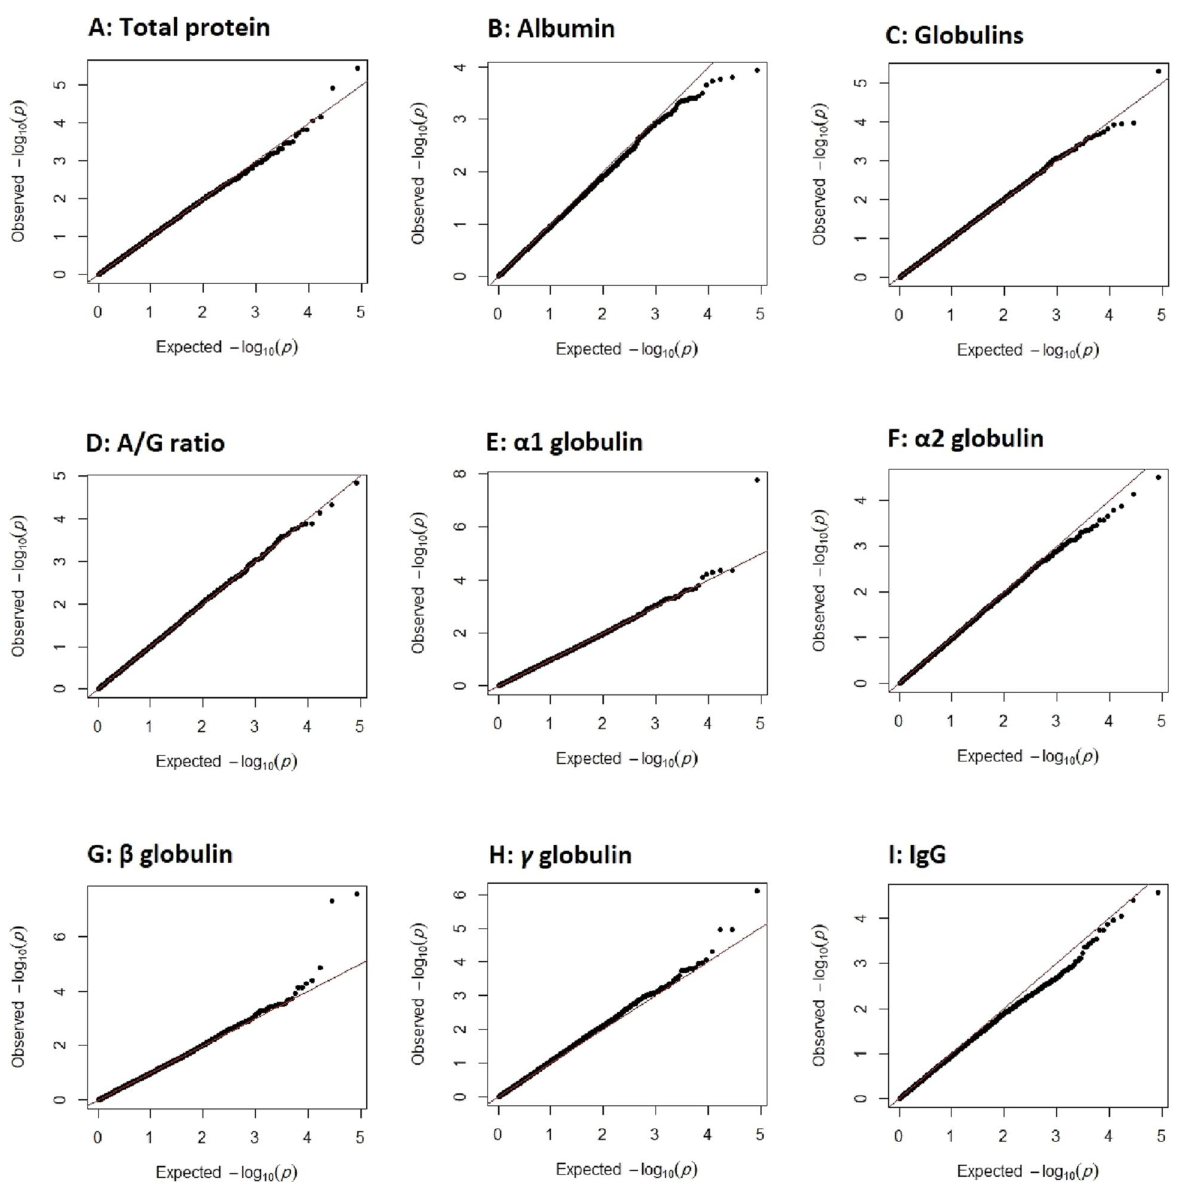
Figure 2. Quantile–quantile (Q–Q) plots for total protein ( A ), albumin ( B ), globulins ( C ), albumin/globulin ratio ( D ), α1 globulin ( E ), α2 globulin ( F ), β globulin ( G ), γ globulin ( H ) and IgG (I). The dots are GWAS − log10 ( p values) and the line represents the expected values for no association.